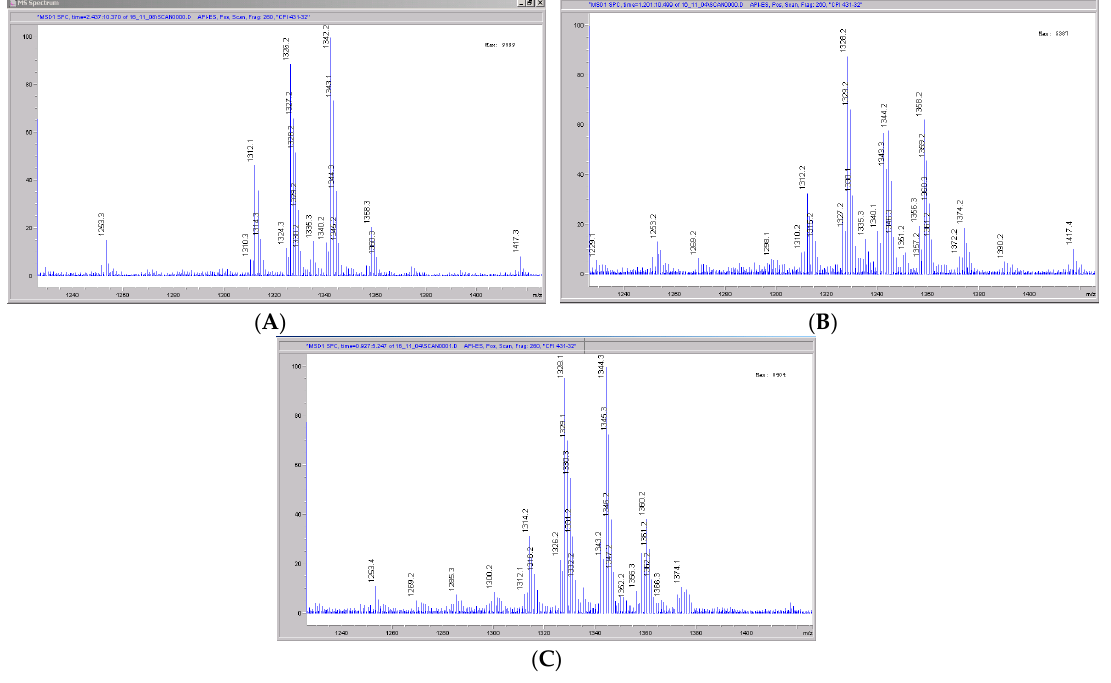
Figure 8. Mass spectral scans of monkey liver extracts incubated with CRV431. Monkey liver microsomes (1 mg/mL) were incubated with 1 μ g/mL CRV431, and extracts were removed for analysis by ESI-LCMS at 5 min (panel ( A ), mass spectral scan from 1260–1460 m/z ), 20 min (panel ( B ), mass spectral scan from 1260–1460 m/z ) and 80 min (panel ( C ), mass spectral scan from 1260–1460 m/z ).